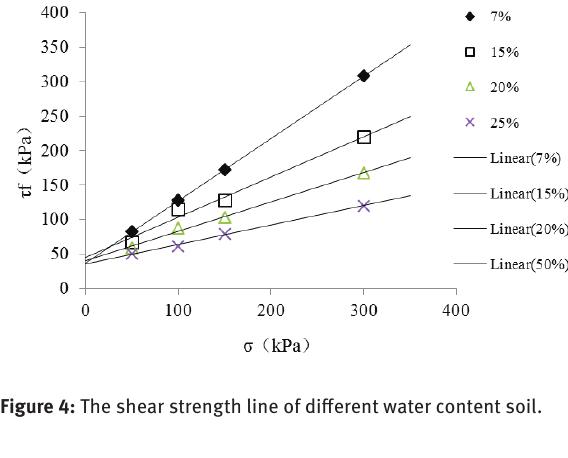
Figure 4: The shear strength line of different water content